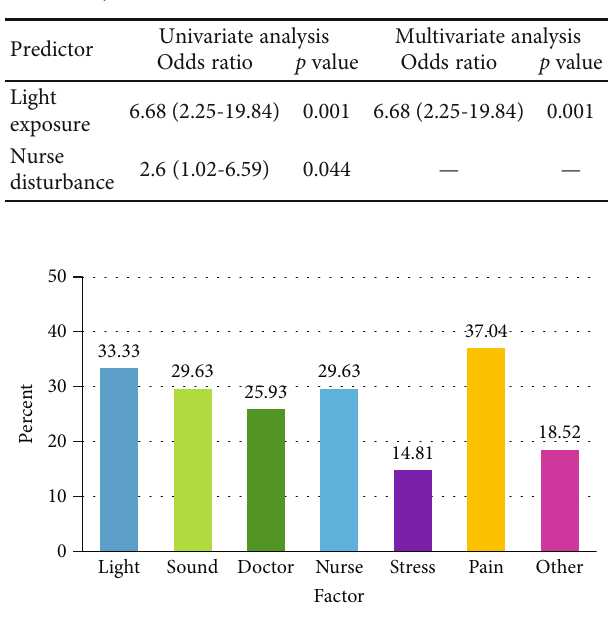
Figure 1: Factors reported in patients with poor sleep quality on the fi rst day. ∗ Other factors included cold temperature, hot temperature, cough, being in di ff erent place, itching, dyspnea, hungry, mosquito, polyuria, procedure, and disturbance by visitors. Table 5: Predictors of poor sleep quality in hospitalized patients on the fi rst day.